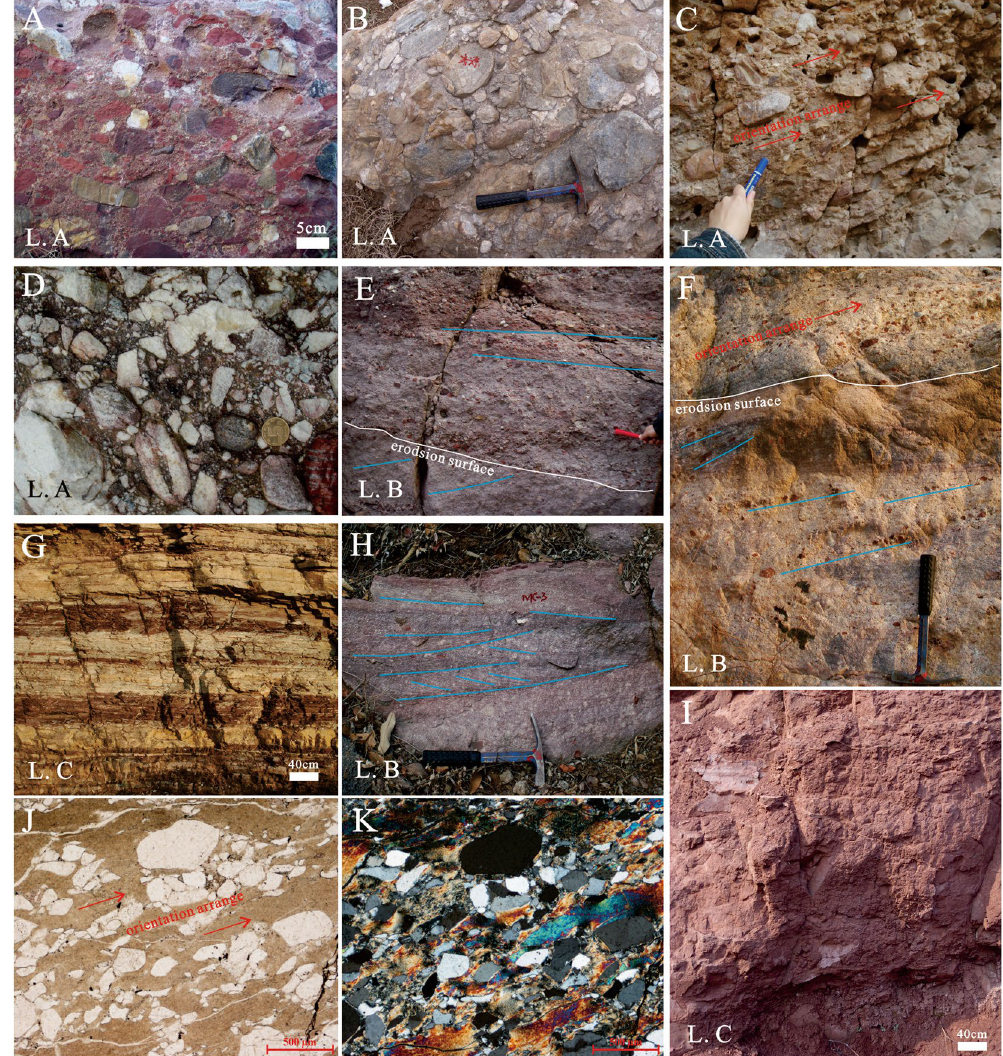
Figure 4. Outcrop and microscopic characteristics of Bingmagou Formation rocks in the Shaoyuan and Mianchi regions. ( A and B ) Grain-supported conglomerate in the Shaoyuan region, with a complex gravel composition, various grain sizes, poor sorting, poor roundness, and no obvious sedimentary structures. ( C ) Matrix-supported conglomerate in the Mianchi region, with oriented gravel clasts (long axis parallel to the bedding plane). ( D ) Grain-supported conglomerate in the Mianchi region without obvious sedimentary structures, in which gravel clasts are mostly quartzite and gneiss. ( F ) Conglomeratic sandstone in the Shaoyuan region; the conglomeratic sandstone is interbedded with layered sandstone, and the gravel clasts exhibit directional arrangement. ( E and H ) Conglomeratic sandstone in the Mianchi region, in which the gravels are complex in composition and arranged along the scoured surface or bedding plane. ( H ) Wedged bedding, and laminations inclined unidirectionally within a single layer. ( G ) Purple shale interbedded with greyish brown fine argillaceous sandstone in the Shaoyuan region. ( I) Red sandy mudstone in the Mianchi region. ( J and K ) Microscopic characteristics of argillaceous sandstone in a matrix-supported sandstone, in which the quartz grains are directionally arranged, angular to round, and poorly sorted. ( J ) Plane-polarized light. ( K ) Cross- polarized